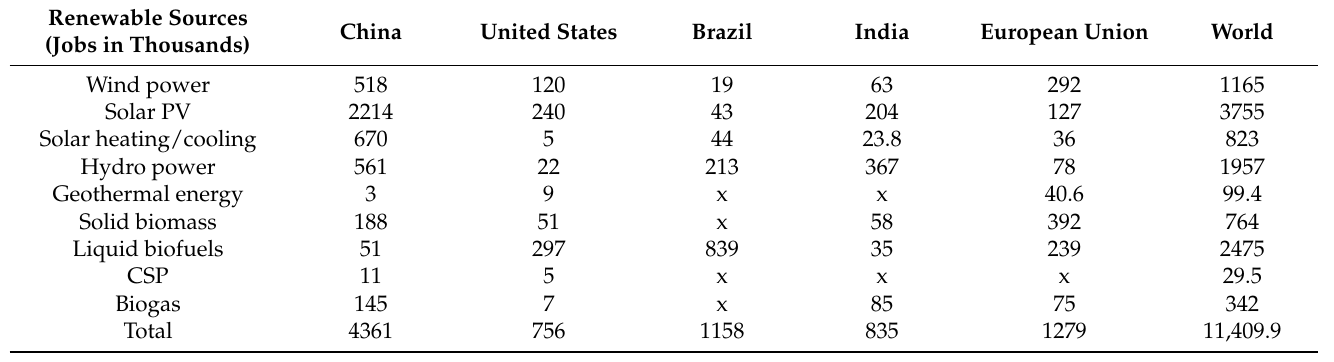
Table 1. Global status of jobs in the renewable energy industry in 2019. Source: Renewable Energy and Jobs [28]. Where, x = data is available.